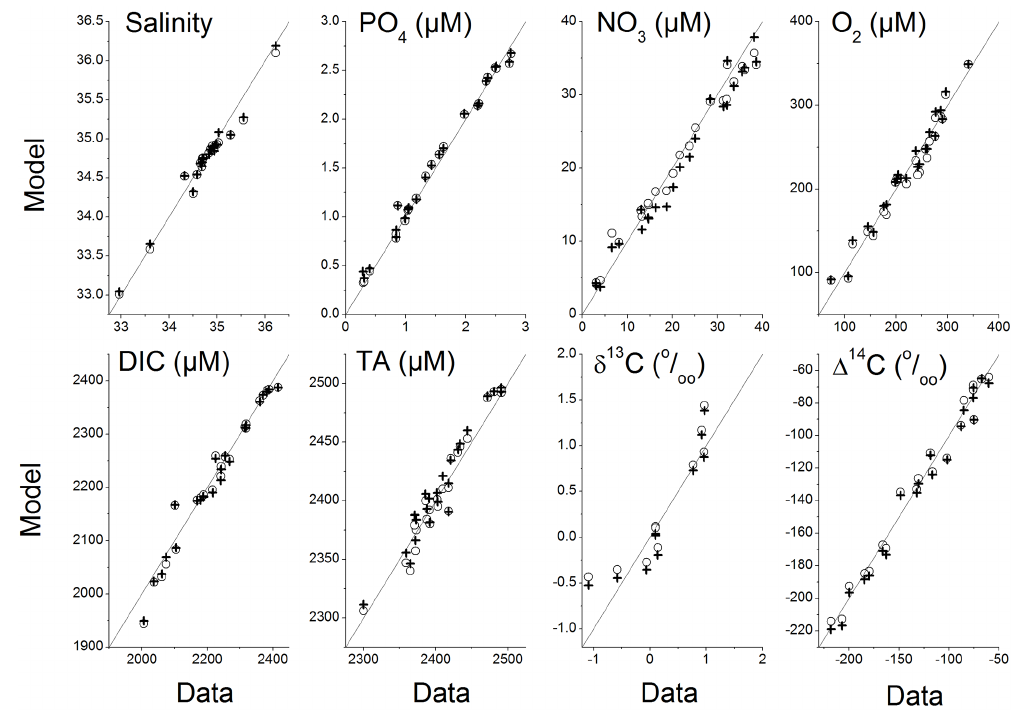
Figure A1. Tracer concentrations in ocean boxes: model vs. data. Open circles indicate concentrations applied as initial values at 130ka (Tables A1 and A2). Crosses are concentrations obtained at the end of simulation STD at 0ka after the completion of a full glacial cycle. Lines indicate the 1 : 1 relationship, e.g. the best fit to the data. δ 13 C data at <2000m water depth are excluded from the model–data comparison since they are affected by anthropogenic CO 2 .